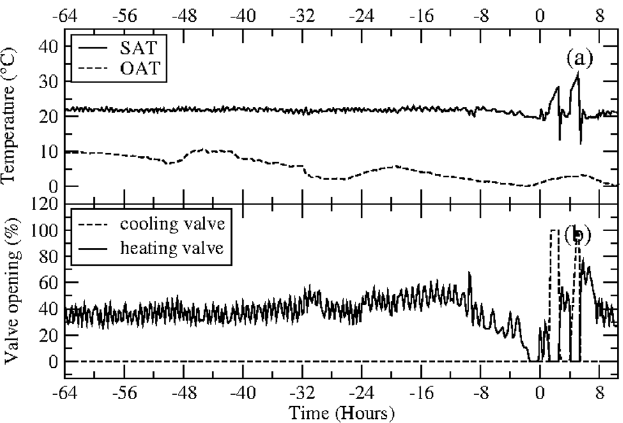
Fig. 1. Plot of sensor variables affecting room temperature. (a) Supply Air Temperature (SAT) and Outside Air Temperature (OAT) in degrees Celsius. (b) Percentage of opening for each of the heating and cooling valves. Plot window starts at 5:30AM of the 25th of January 2019, 64 hours prior to the